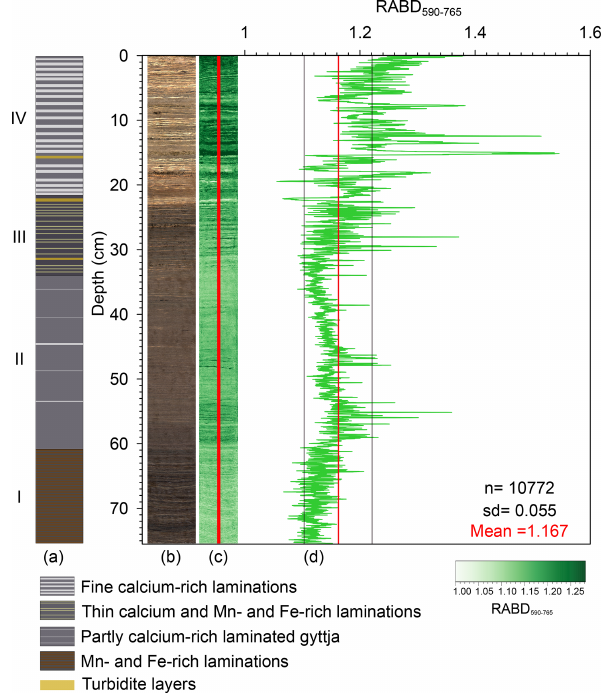
Figure 4. (a) Lithological description of the Burg17-B sediment core. The intensities of Ca, Fe, and Mn in each unit were in- ferred from XRF element counts in Fig. 3; yellow colors highlight the turbidite layers identified from the XRF peaks of siliciclastic elements, e.g., K, Ti, and Rb. (b) RGB contrast-enhanced sedi- ment core picture. (c) The map of the spectral index RABD 590–765 (i.e., green pigments) distribution and (d) the graphic output of the RABD 590–765 spectral index within the boundary of the red lines, (c) which shows the 2mm wide sampling range. The red line in (d) indicates the mean index value and the gray lines represent 1 deviation (SD). The color bar represents the index values of the dis- tribution map (color figure online). n is the number of rows of the RABD 590–765 index